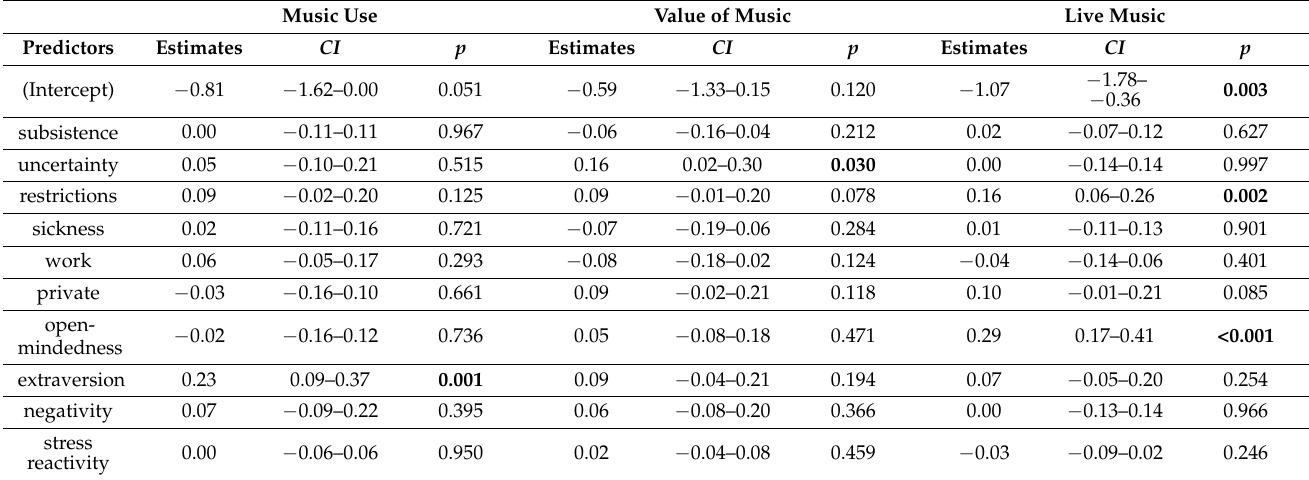
Table 8. Results of the linear models predicting perceived changes in musical